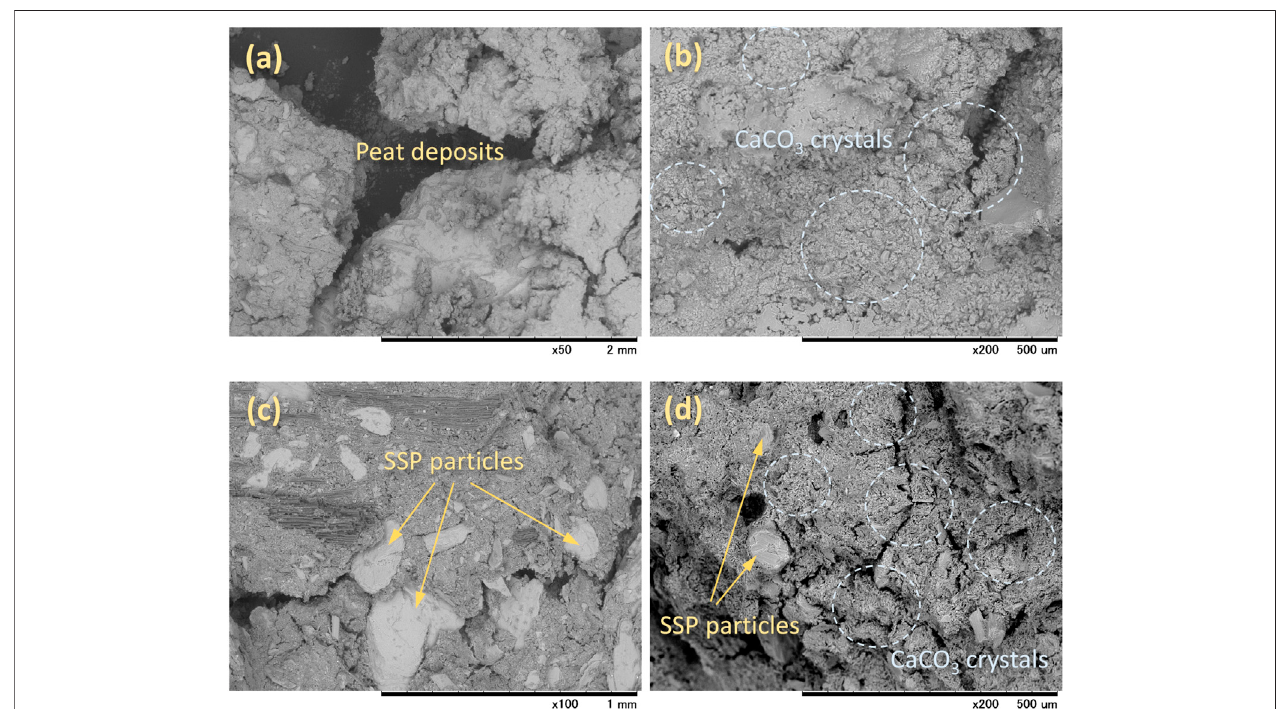
FIGURE 10 | Micrographs of the (A) untreated peat, (B) peat treated by MICP alone, (C) peat treated by SSP alone, and (D) peat treated by MICP + SSP.